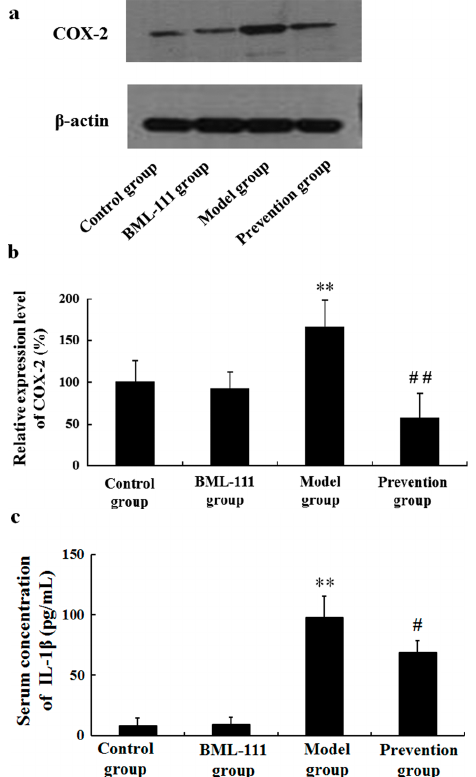
Figure 4. BML-111 inhibited LPS/ D -GalN induced COX-2 and IL-1 β . ( a ) Western blot analysis of COX-2. The COX-2 band (72 kDa) and the β -actin band (43 kDa) are indicated; ( b ) blots obtained from several experiments were analyzed using densitometry, and the densitometric values are shown as means ± SD ( n = 3); ( c ) The levels of IL-1 β in serum were measured via ELISA. ** p < 0.01 compared with the control group, # p < 0.05, ## p < 0.01 compared with the model group ( n = 6).